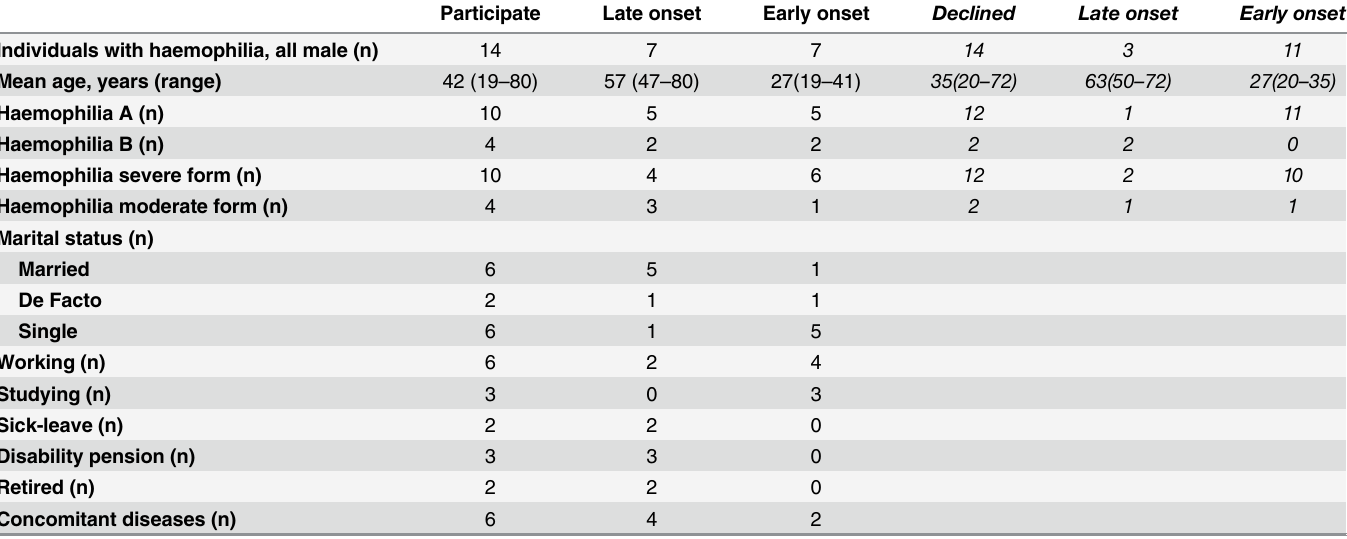
Table 3. Demographics of the participants and the PWH who declined participation in italic